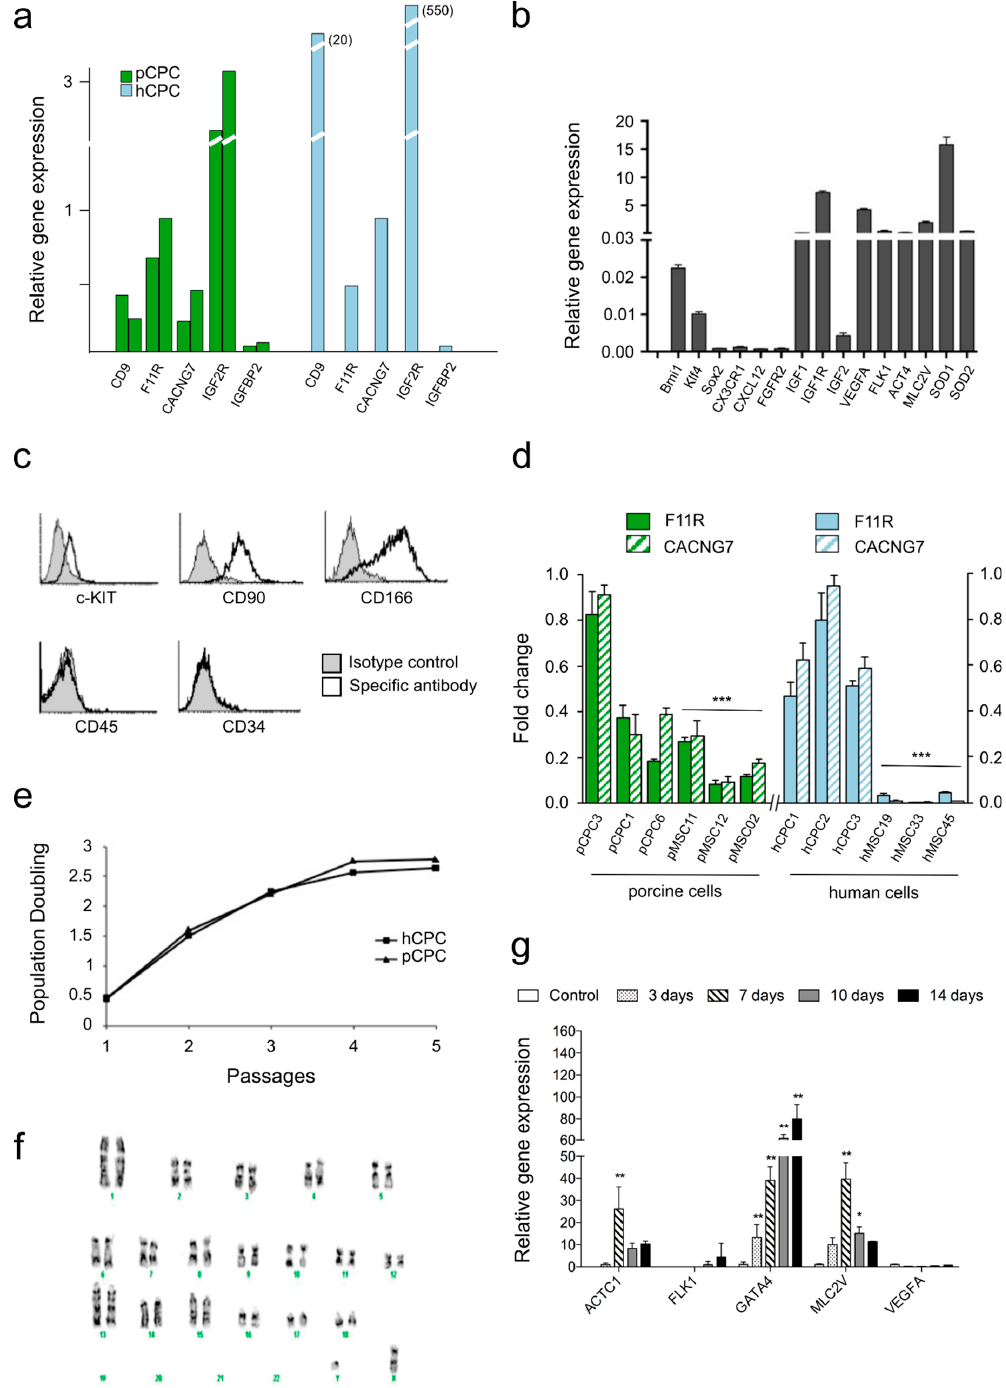
Figure 2. Comparative characterization of pCPC with hCPC. ( a ) Relative gene expression levels analyzed by RT − qPCR in pCPC and hCPC of five selected relevant genes, previously characterized in hCPC. ( b ) Global RT − qPCR expression analysis of pCPC. ( c ) Flow cytometry analysis of pCPC relevant surface markers. ( d ) Expression of F11R and CACNG7 in different porcine and human CPC and MSC cell isolates. ACTB was used as housekeeping gene ( n = 3). *** p < 0.001 vs. pCPC3. ( e ) Representative parallel population doubling analysis in pCPC compared with hCPC. ( f ) Normal pCPC karyotype from a representative cell batch at culture passage 6. ( g ) Cardiogenic differentiation of pCPC in 2D culture during two weeks with dexamethasone (10 mM); some relevant genes were monitored at different stages of cardiogenic differentiation. ACTB was used as housekeeping gene ( n = 3). * p < 0.05, ** p < 0.01 vs.